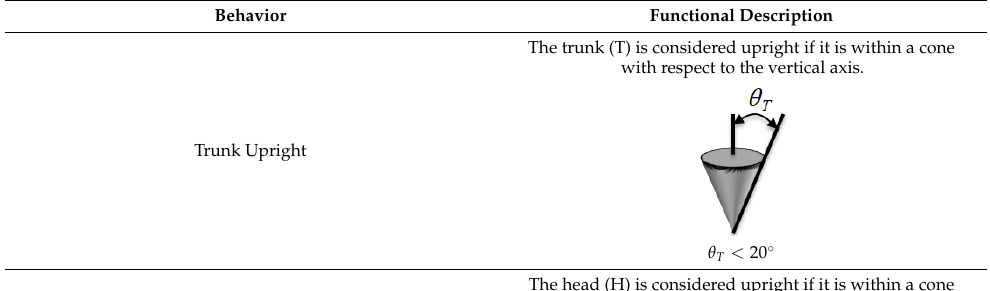
Table 2. Functional description of behaviors.